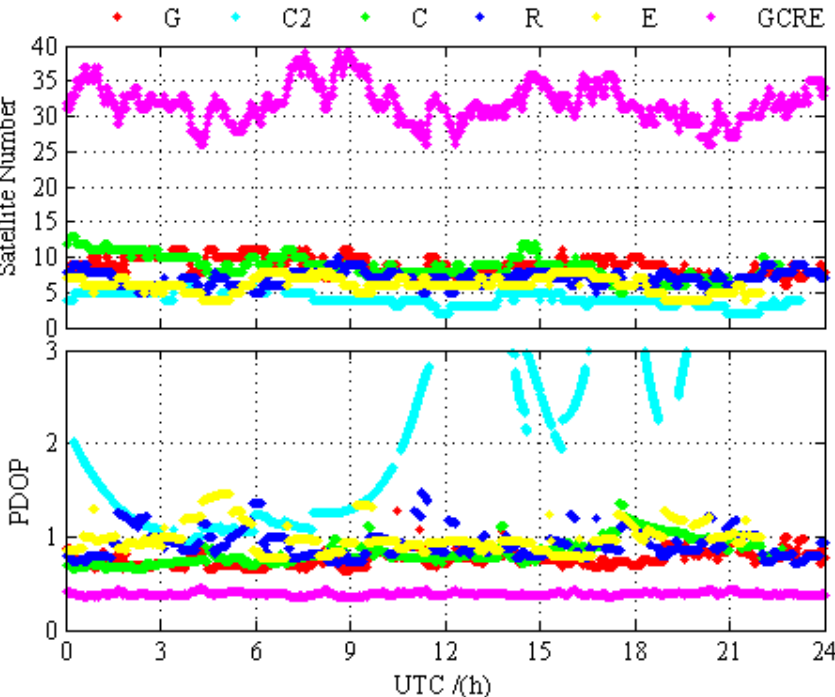
Figure 4. Number of satellites and PDOP at BRCH for GPS-only, BDS-2-only, BDS-2/BDS-3, GLONASS-only, Galileo-only, and GPS/BDS-2/BDS-3/GLONASS/Galileo on DOY 024 in 2019.